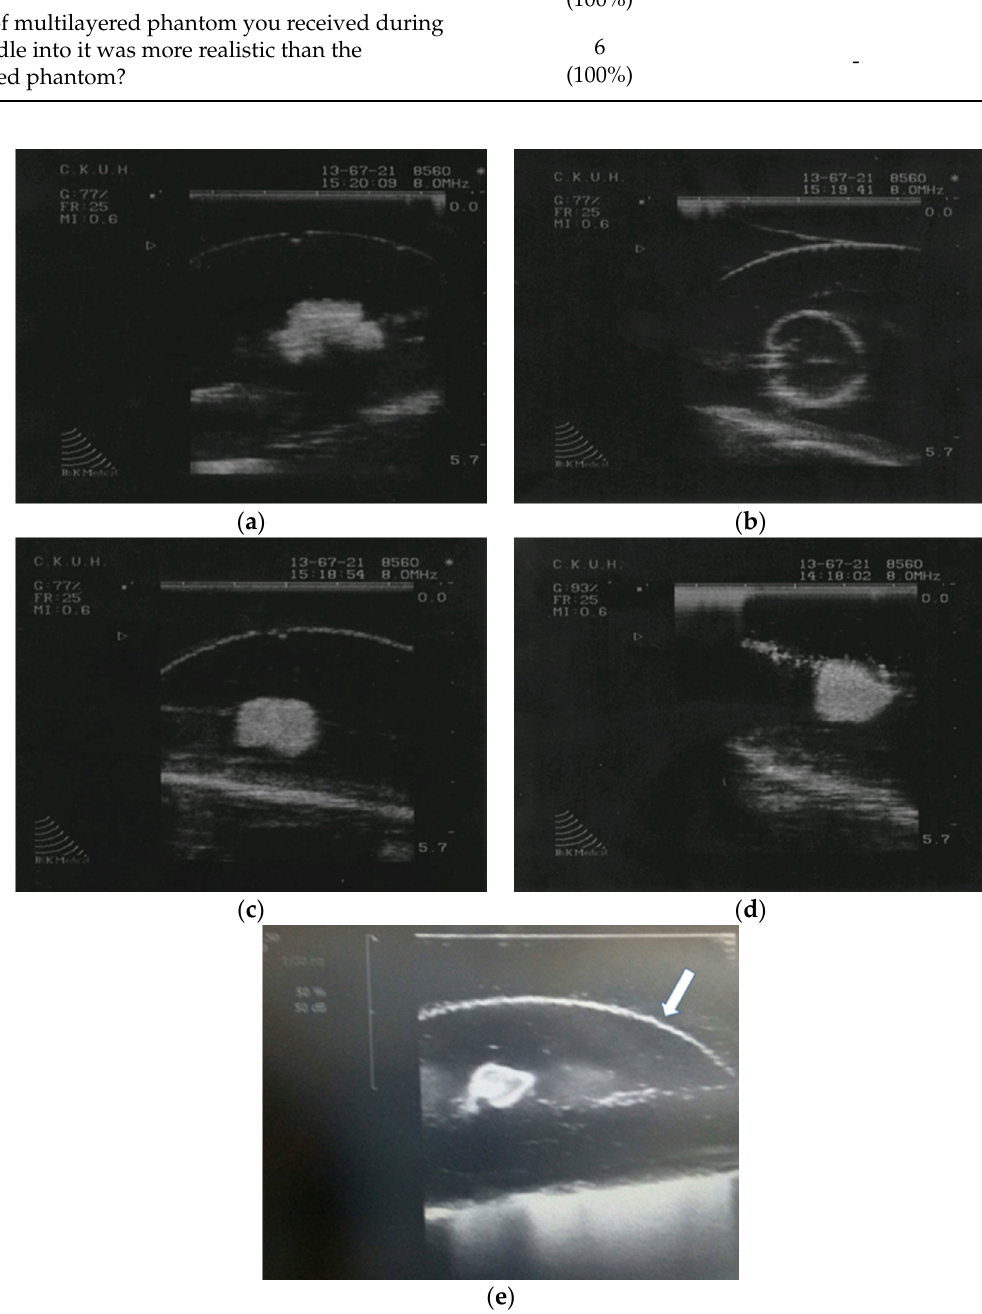
Figure 7. Ultrasound images for embedded tumors and artefact in multi-layered gelatin-based phantom. ( a ) Malignant tumor (Shallot); ( b ) Cyst (Rubber glove finger filled with colored solution); ( c ) Benign tumor (Dried agar konjac); ( d ) Benign tumor (Dried sweet potato); ( e ) Artefact caused by the boundary between the fat and glandular tissues is indicated by the white arrow.